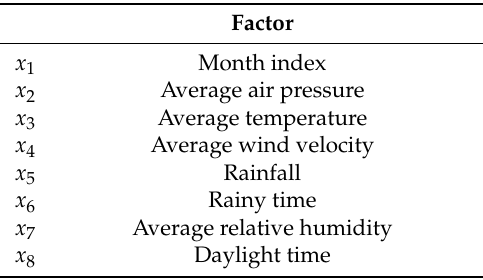
Table 1. Factors used for electricity